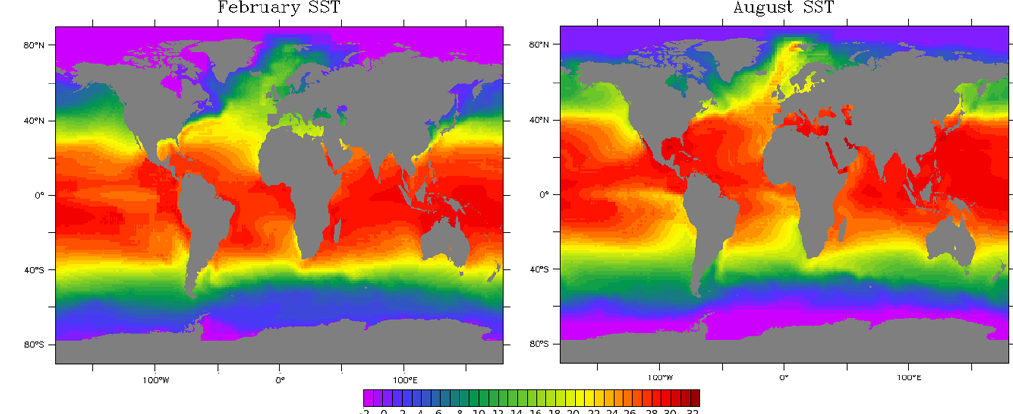
Fig. 3. Mid Pliocene sea surface temperatures imposed for February (left) and August (right), expressed in degrees